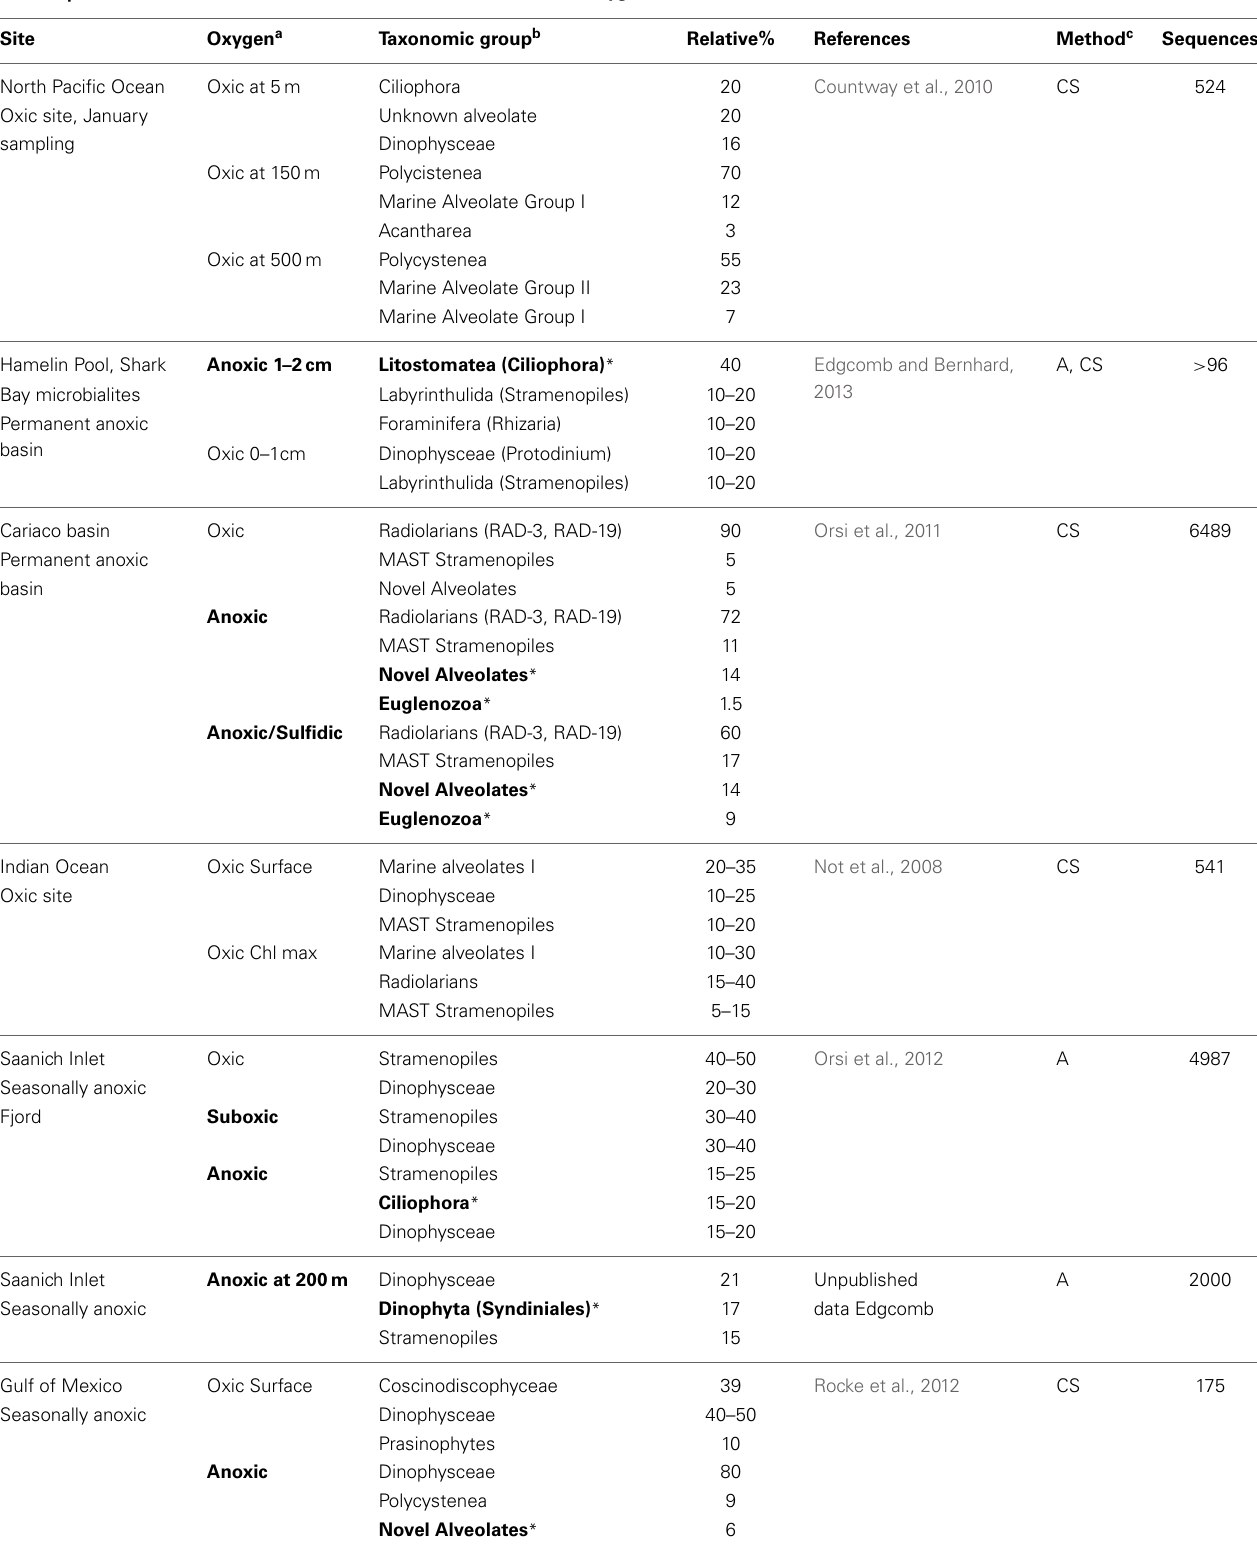
Table 2 | Relative abundance of dominant taxa across diverse low oxygen